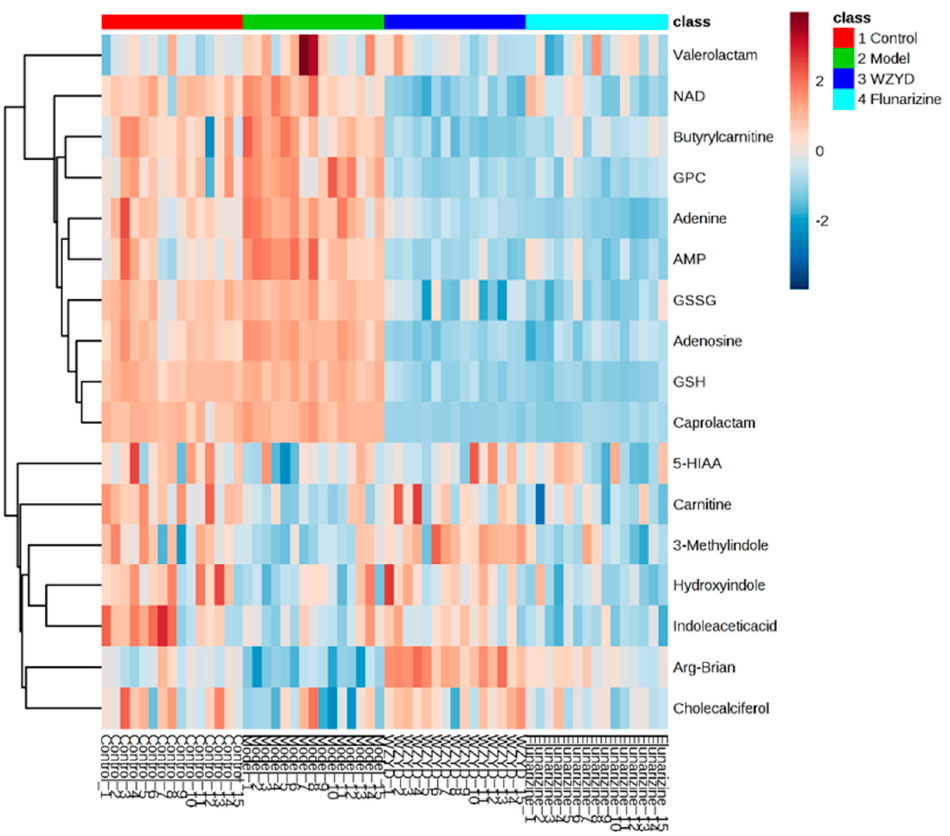
Figure 3. The hierarchical clustering heatmap of the potential biomarkers.